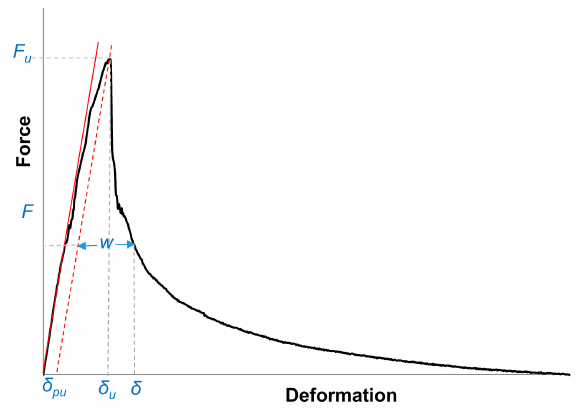
Figure 10. Schematic view of deformation components for a complete deformation controlled uniaxial tensile